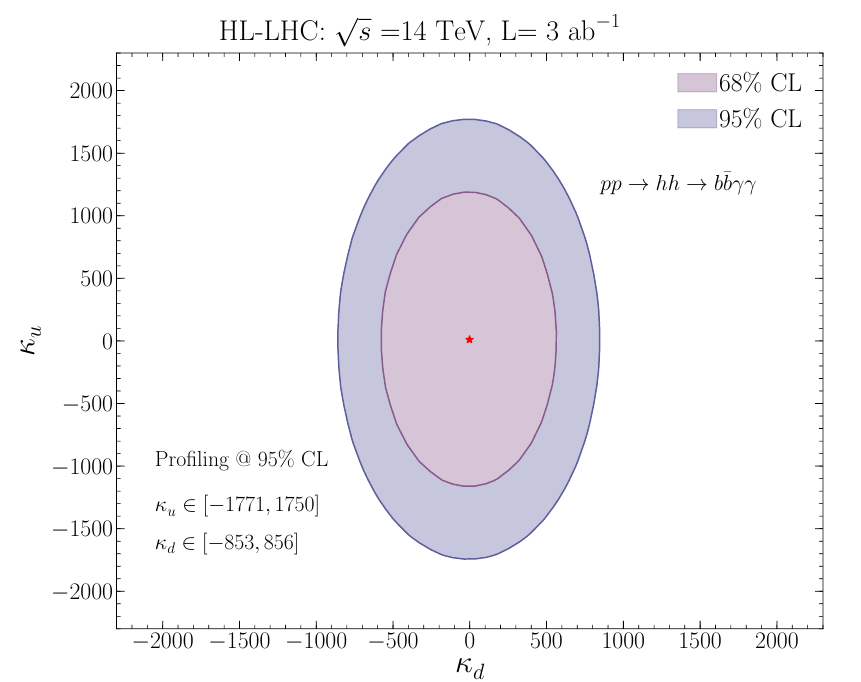
Figure 13 . The expected sensitivity likelihood contours at 68% and 95% CL of the HL-LHC for the (cid:12)rst generation Yukawa coupling